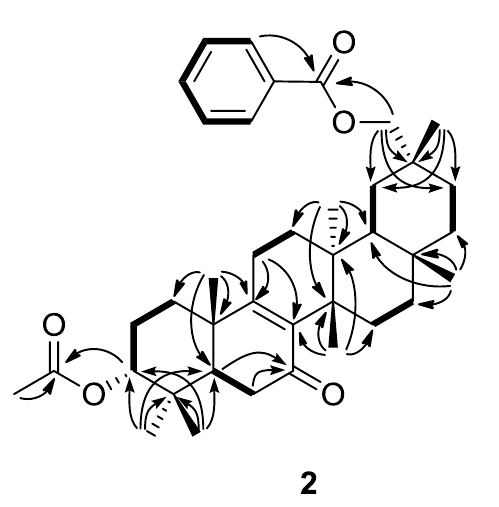
Figure 4. Key HMBC ( ) and 1 H- 1 H COSY ( ) correlations of 2